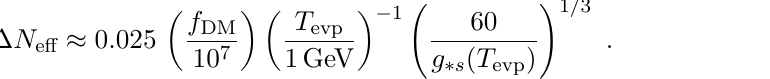
JHEP10(2021)147